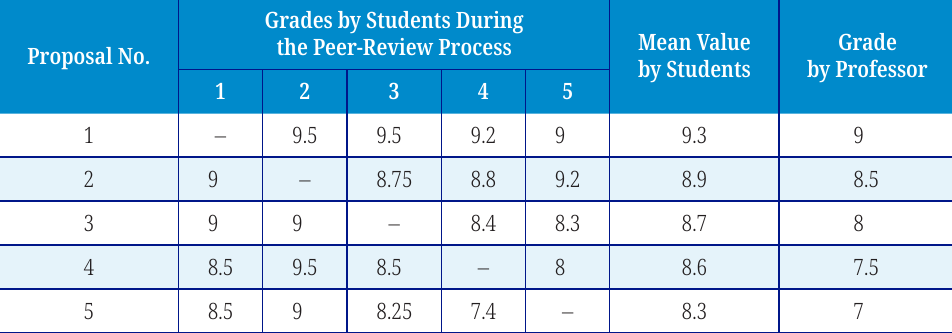
Table 3. Results of the peer-review process of self-videos by students and grades given by the professor (from 0 to 10)